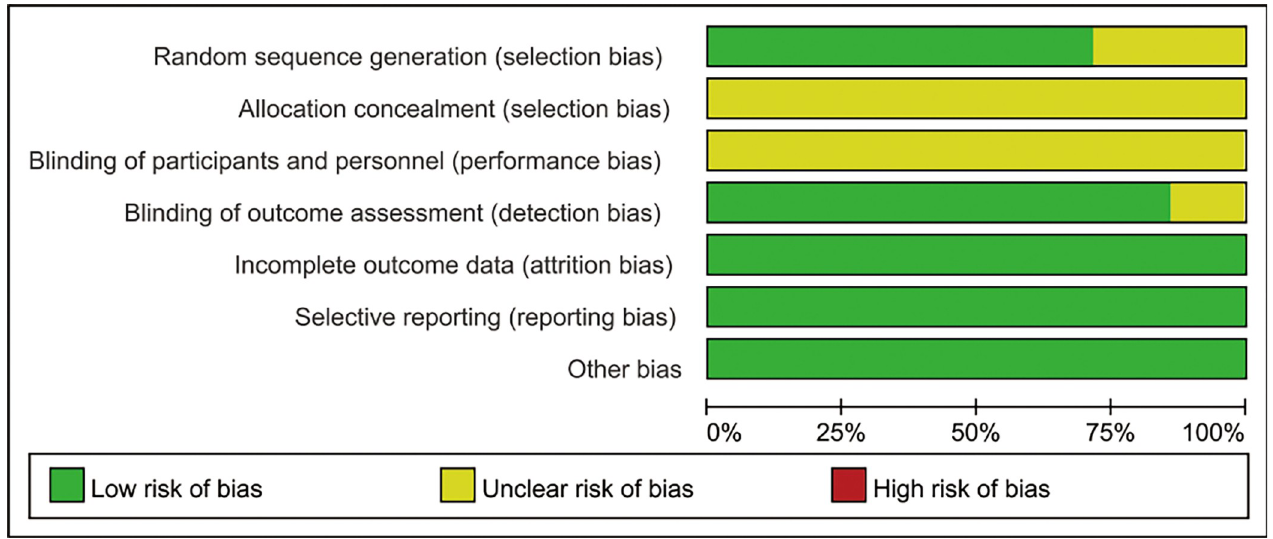
Fig 2. Risk of bias